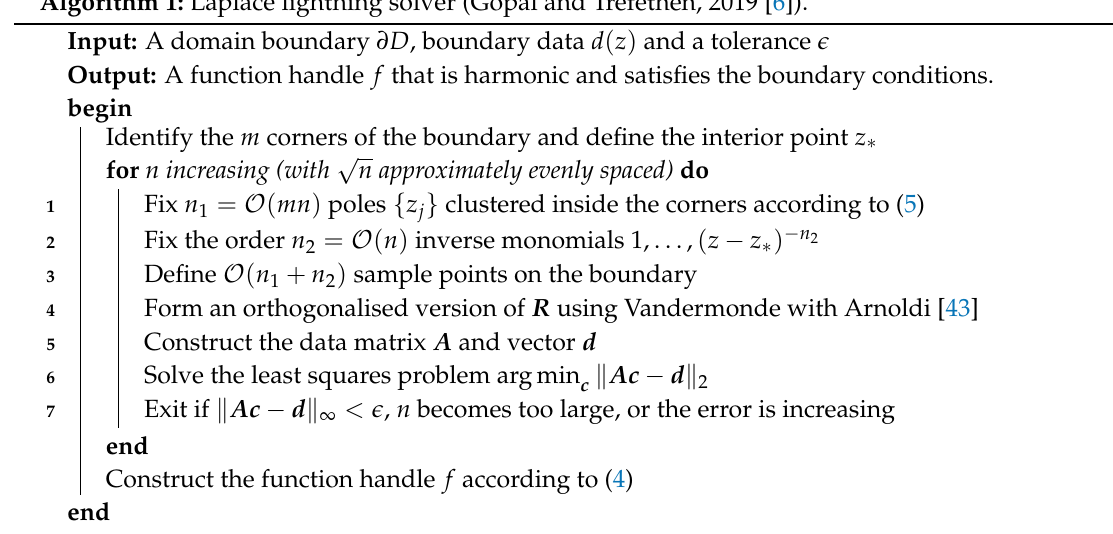
Algorithm 1: Laplace lightning solver (Gopal and Trefethen, 2019